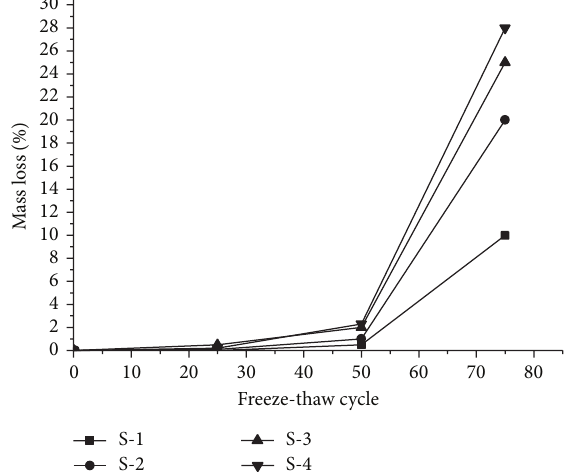
Figure 4: Mass loss of concrete cores after freeze-thaw cycles.